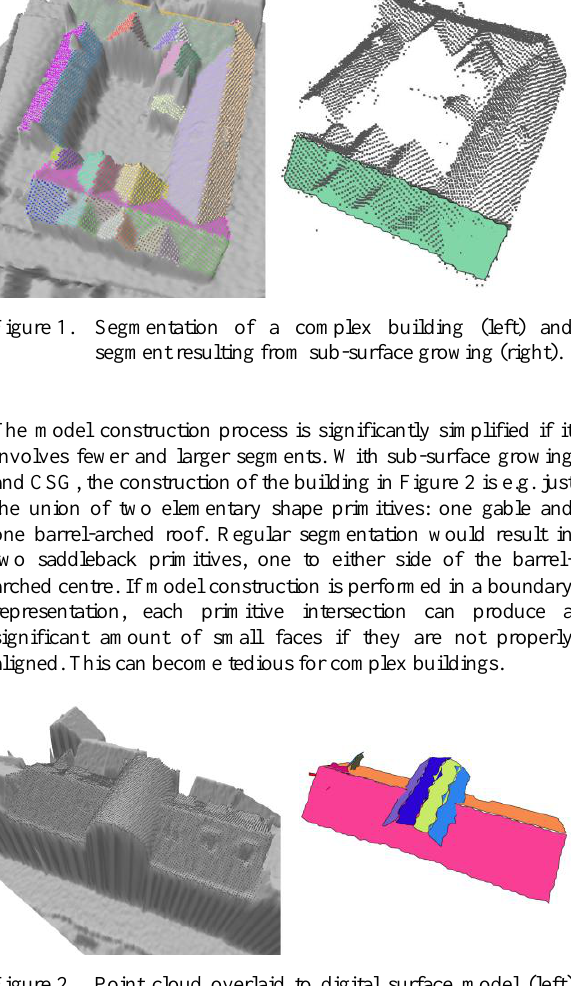
Figure 2. Point cloud overlaid to digital surface model (left) and sub-surface segments (right).